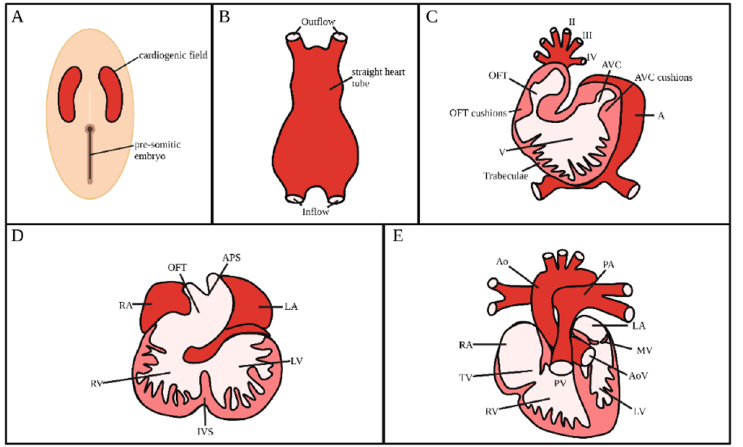
Figure 1. Developmental landmarks of cardiac development. ( A , B ) Cells located within the cardio- genic field migrate towards the midline to form a straight heart tube. ( C ) The heart begins to loop and can be compartmentalized into the primitive atria, atrioventricular canal, primitive ventricle, and outflow tract. Concurrent with heart looping, sheet-like projections called trabeculae begin to form. ( D ) Once heart looping is complete, septation (division) initiates within the ventricles, atria, and outflow tract. The outflow tract continues to rotate to align the future aorta and pulmonary artery with their respective ventricle. ( E ) The normal mature heart consists of two atria, two ventricles, four valves, as well as aortic and pulmonary outlets. OFT: outflow tract; AVC: atrioventricular canal; V: primitive ventricle; A: primitive atria; RA: right atria; LA: left atria; RV: right ventricle; LV: left ventricle; APS: aorticopulmonary septum; IVS: interventricular septum; Ao: aorta; PA: pulmo- nary artery; MV: mitral valve; AoV: aortic valve; TV: tricuspid valve; PV; pulmonary valve; II, III, IV: aortic arches II, III, IV. Created with BioRender.com (accessed on 24 July 2022).